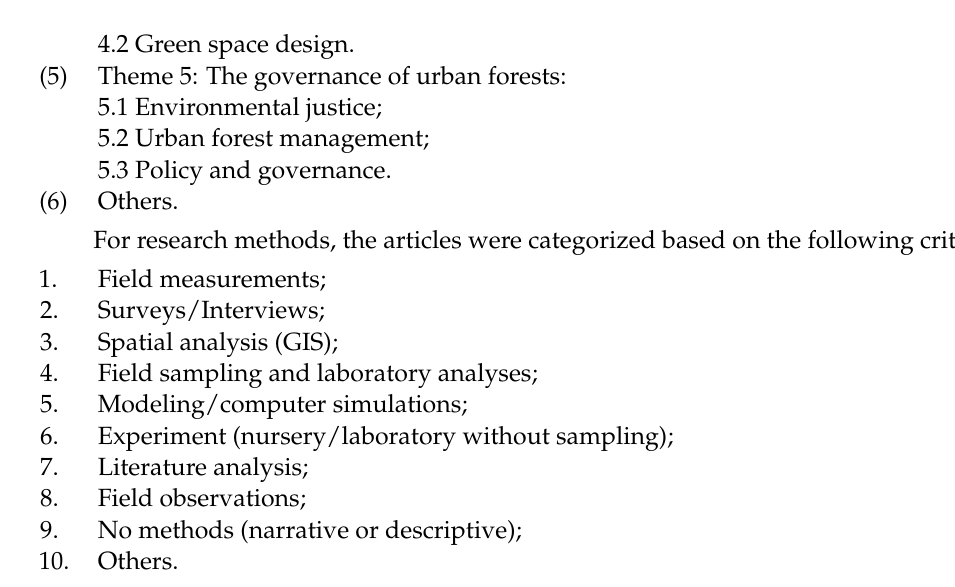
Figure 3. Distribution of articles every five years ( n = 43). 3.2. Distribution of Articles Based on Location The number of articles varied significantly based on location (Figure 4). The data showed that some states such as Selangor ( n = 15) and Kuala Lumpur ( n = 11) accounted for almost one-third of articles while there were four states that only had one paper each, which were Terengganu, Kedah, Sarawak, and N. Sembilan. Moreover, there were states that did not have any papers, for instance, Perak and Kelantan. There were four articles that conducted their studies in multiple locations [11–14]. There was also a study con- ducted throughout Peninsular Malaysia, whereby the research was on the prevalence of dengue among residents residing on the fringe areas of urban forests [15].